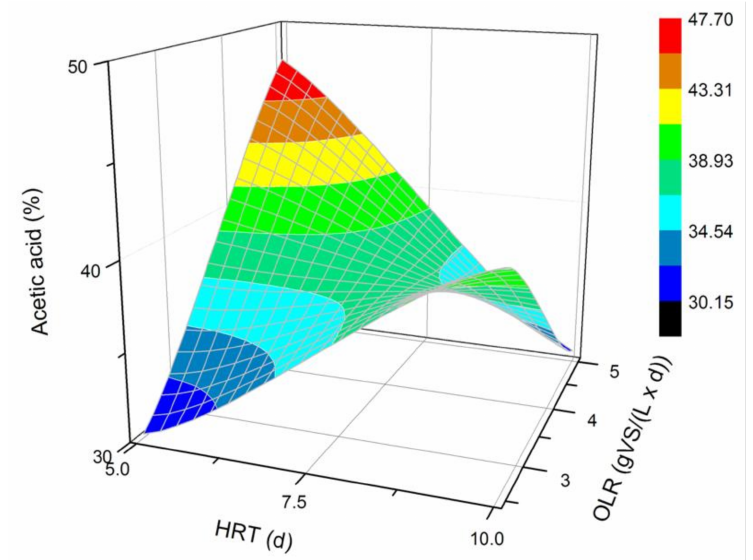
Figure 2. Changes in the content of acetic acid produced in a steady state during the DF process at the OLRs of 2.5 gVS/(L × d) and 5.0 gVS/(L × d) and HRTs of 5 d and 10 d.